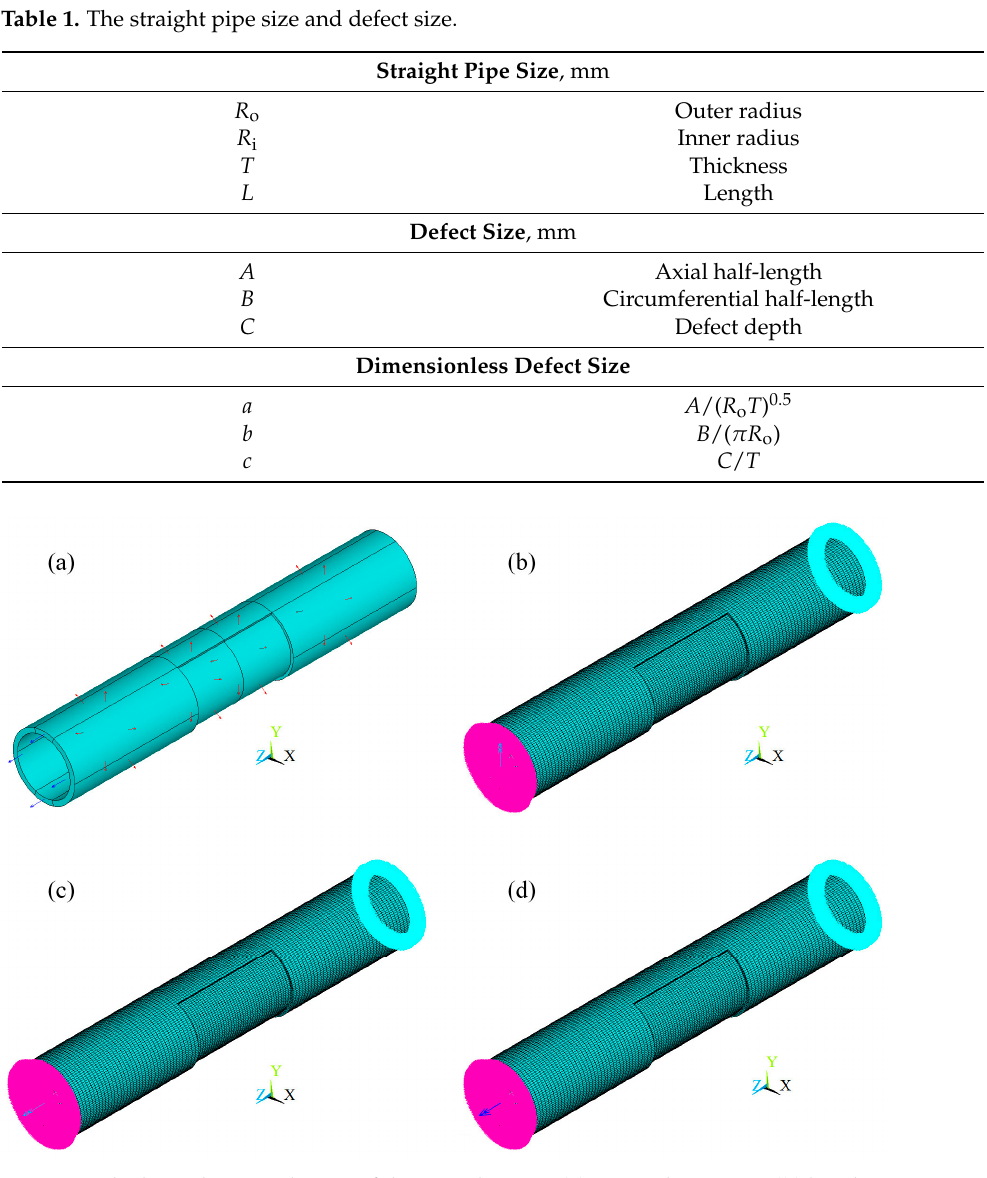
Figure 2. The boundary conditions of the straight pipe: ( a ) internal pressure; ( b ) bending moment; ( c ) torque; ( d ) axial force.